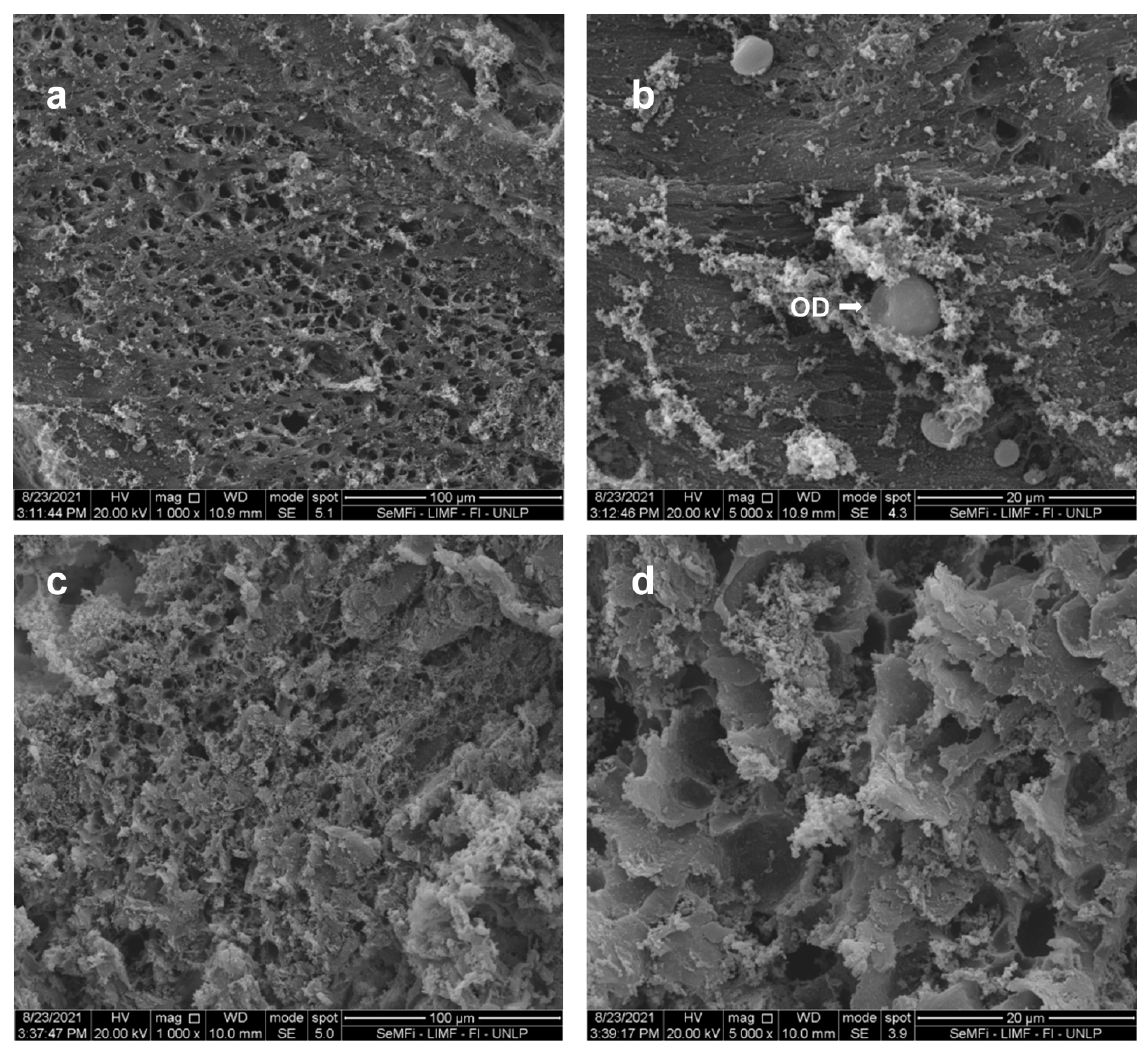
Figure 4. Scanning electron micrographs of the control burger (C-B): raw ( a , b ) and cooked ( c , d ). OD: oil droplet.